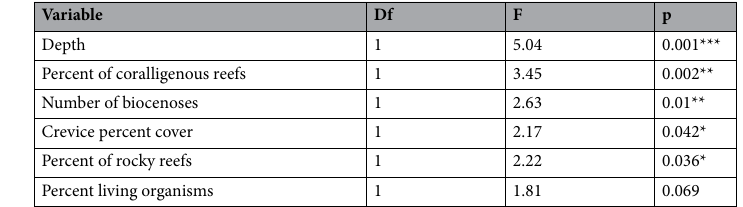
Table 2. Results of Canonical correspondence analysis testing for a link between acoustic communities and environmental variables (N = 27). Only relevant metrics resulting from the stepwise variable selection are